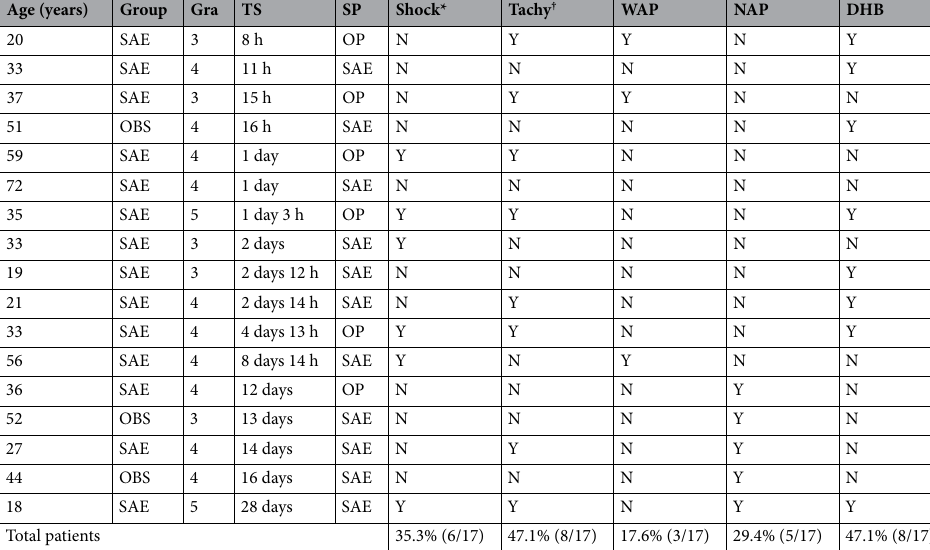
Table 2. Characteristics of patients that underwent salvage procedures. *systolic blood pressure < 90 mmHg, † heart rate > 120 beat/min. SAE splenic artery embolization, OBS observation, SBP systolic blood